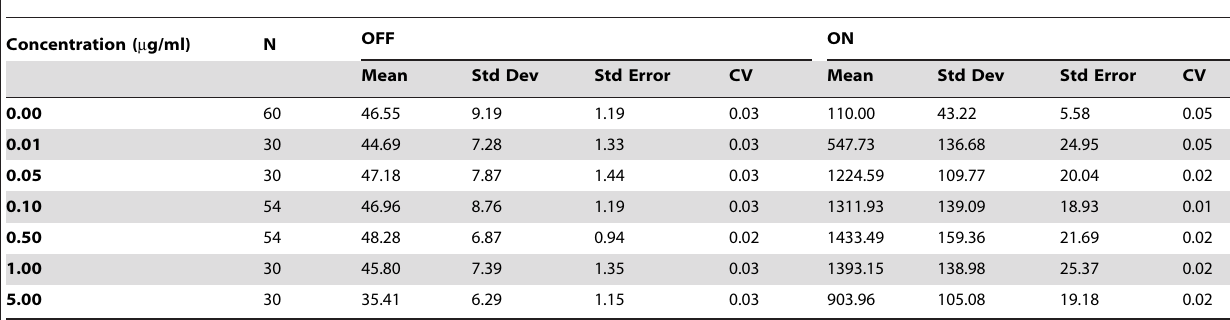
Table 2. Descriptive Statistics of Signals by Concentrations (GnRHR).